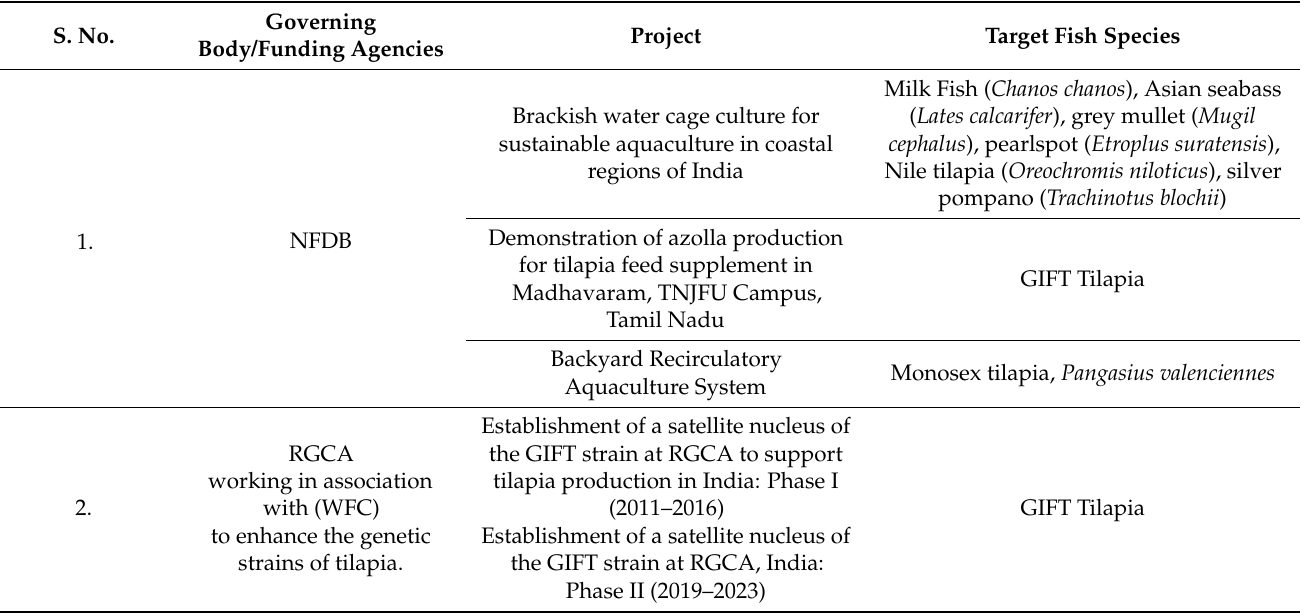
Table 5. Projects and schemes for tilapia culture in